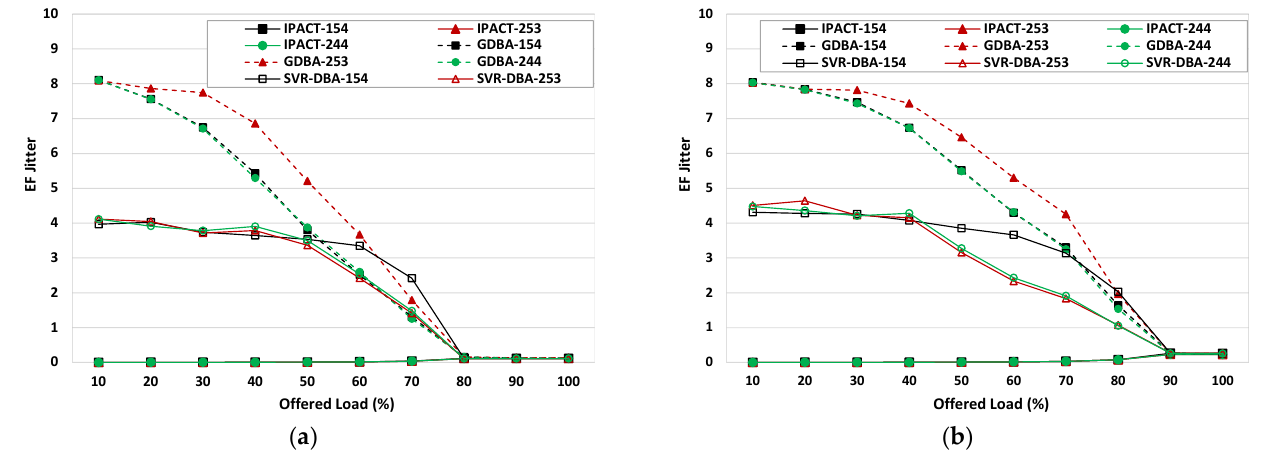
Figure 6. EF jitter for different scenarios. ( a ) EF jitter for 1.0 ms cycle time; ( b ) EF jitter for 1.5 ms cycle time.